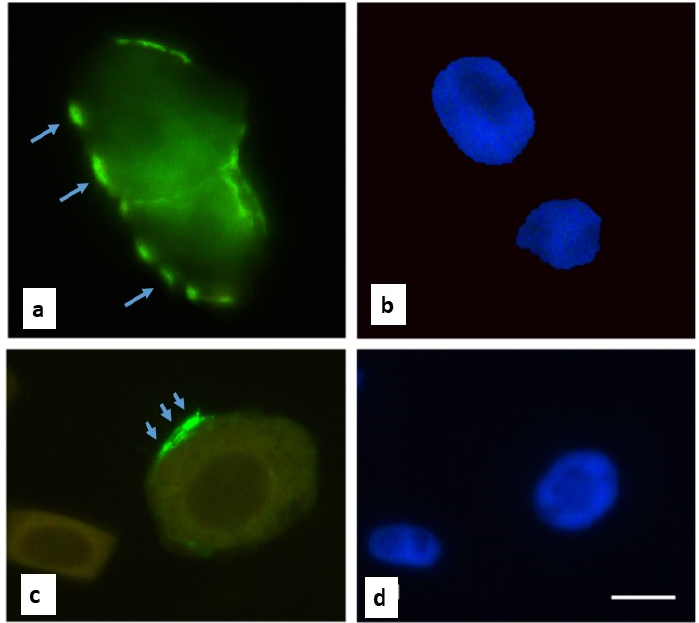
Figure 7. Localization of phosphatidylserine on the surface of plasma membranes of root cells of 4- day-old seedlings of Triticum durum variety Zolotaya in the presence of 150 mM NaCl. ( a , c )—Clus- ters of phosphatidylserine on surface plasmatic membranes (Annexin V-FITC), blue arrows; ( b , d ) — nuclei of cells (DAPI). Bar 200 μ m.